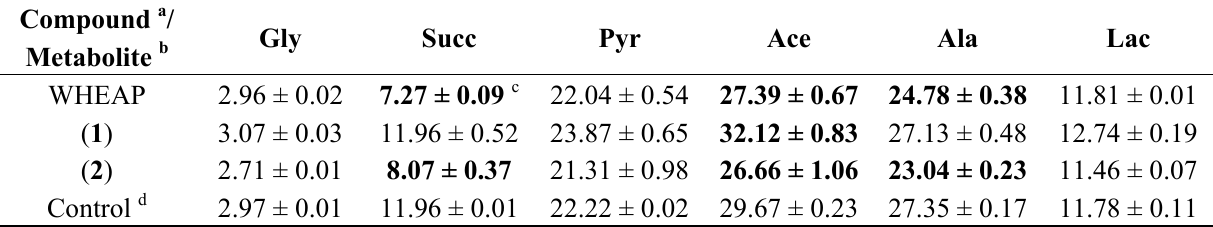
Table 2. Results in metabolomic studies using 1 H-NMR (for details see Experimental Section). Each run was done in triplicate.